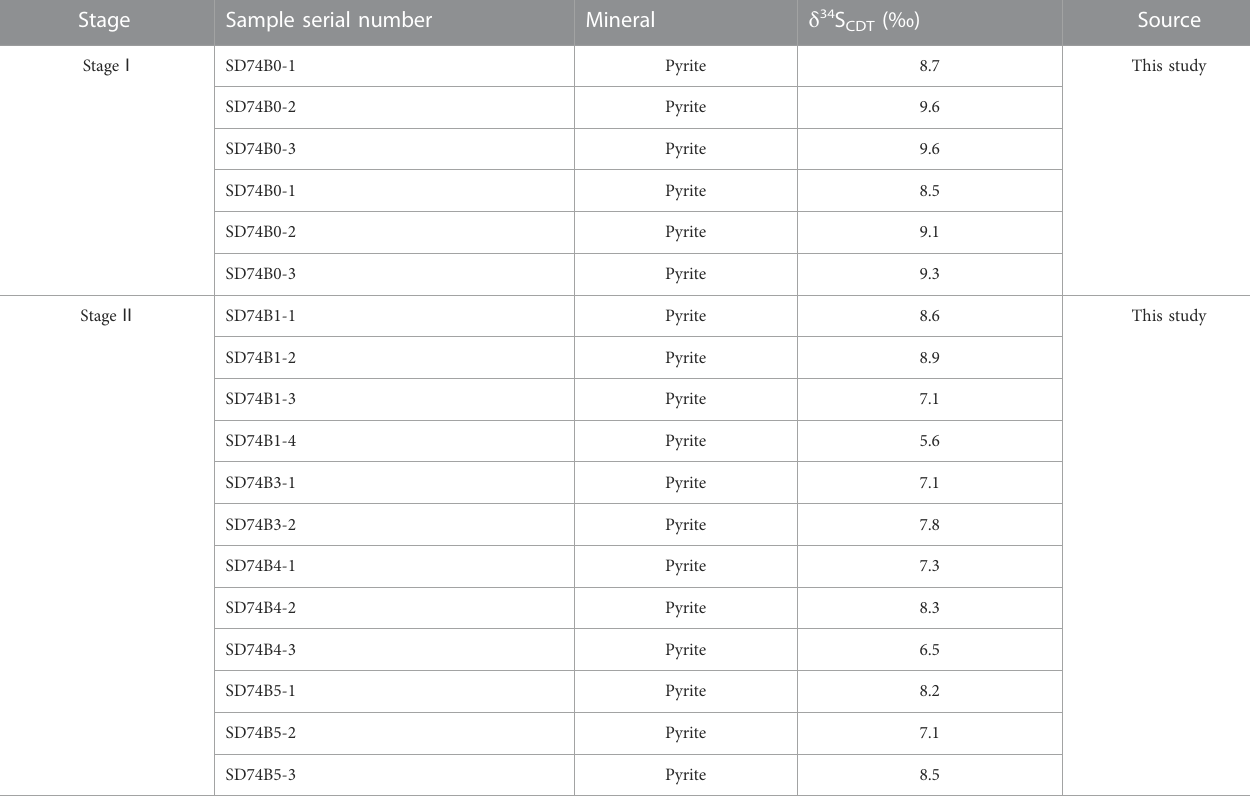
TABLE 1 LA-MC-ICP-MS in situ S isotopic compositions of different hydrothermal stages of pyrites from the Yangjiakuang gold deposit.